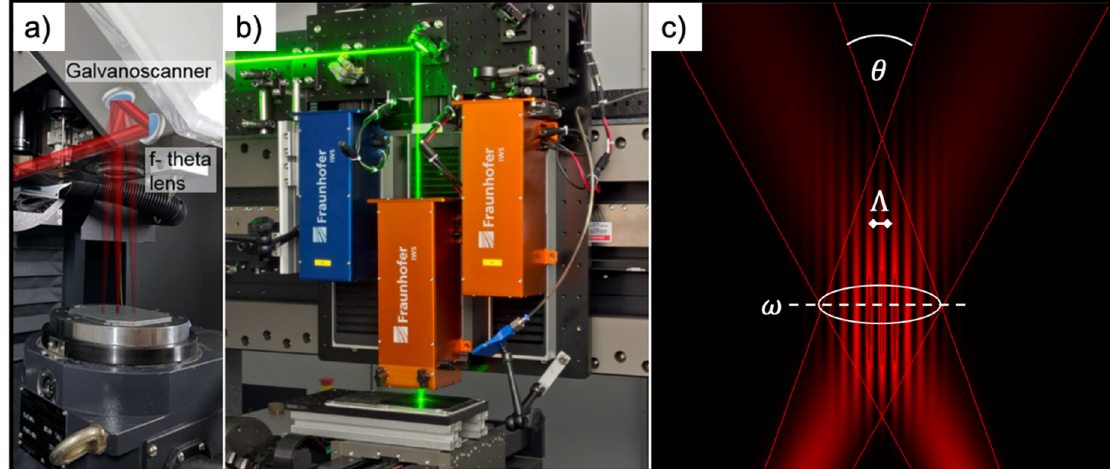
Figure 1. DLW (direct laser writing) configuration equipped with a galvanoscanner and an f-theta-lens used in the experiments ( a ), 3D-DLIP workstation (developed at the Technische Universität Dresden) with a 1064 nm wavelength laser source emitting 10 ps pulses for the processing of 2D and 3D parts (( b ), the visible laser beam illustrates the process), graphical representation of the used two-beam direct laser interference patterning (DLIP) principle, showing the most relevant parameters describing both the pattern and the process: ω —beam diameter; θ —beams intersection angle; Λ —laser intensity profile/ablated structure period ( c ) [35,42].